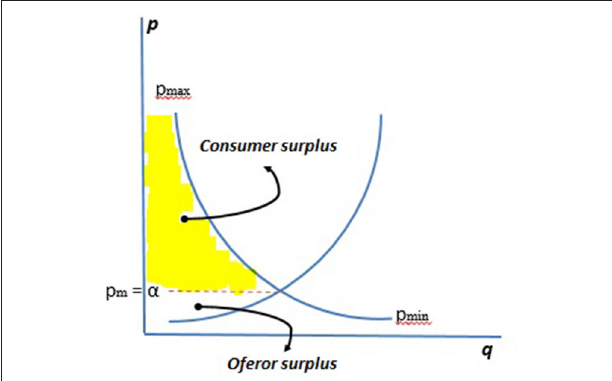
FIGURE 1 | Range qualifying demonstration. Source: own compilation based on Samuelson and Nordhaus